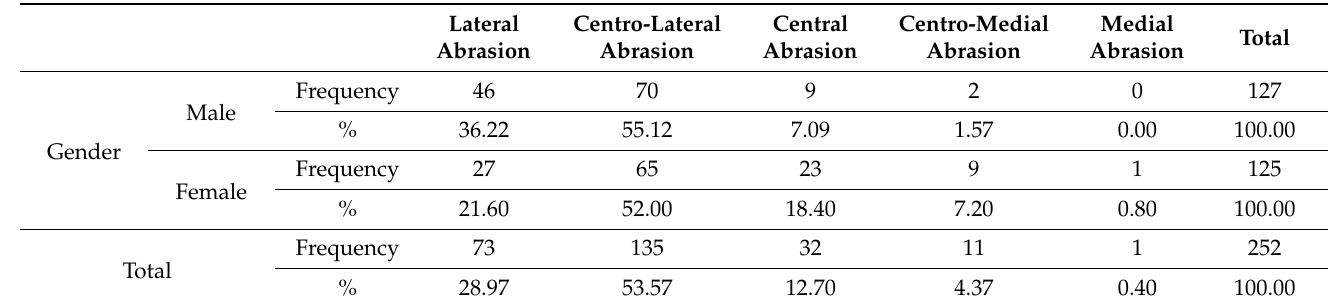
Table 11. Relationship between gender and right shoe abrasion classification (X 2 = 16.69, df = 4, p = 0.00).